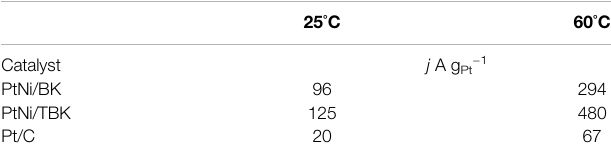
TABLE 4 | Speci fi c mass activities of PtNi/TBK, PtNi/BK and Pt/C electrodes for ethanol oxidation in 1 M EtOH/0.5 M H 2 SO 4 solutionat anapplied potentialof 0.5 V vs. SCE